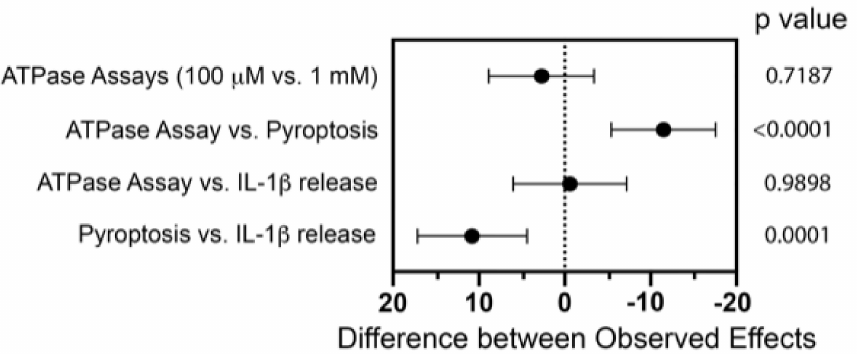
Figure 5. Effect of the experimental method on NLRP3 inflammasome attenuation. The impact of selected compounds on inflammasome outputs (i.e., pyroptosis, ATPase activity, IL-1 β secretion) was assessed by two-way ANOVA with Tukey’s multiple comparison test showing 95% CI. No difference between the observed effects suggests the INF compound administration was similar in outcome. Only those compounds which had been analysed by all three methods were included in the statistical